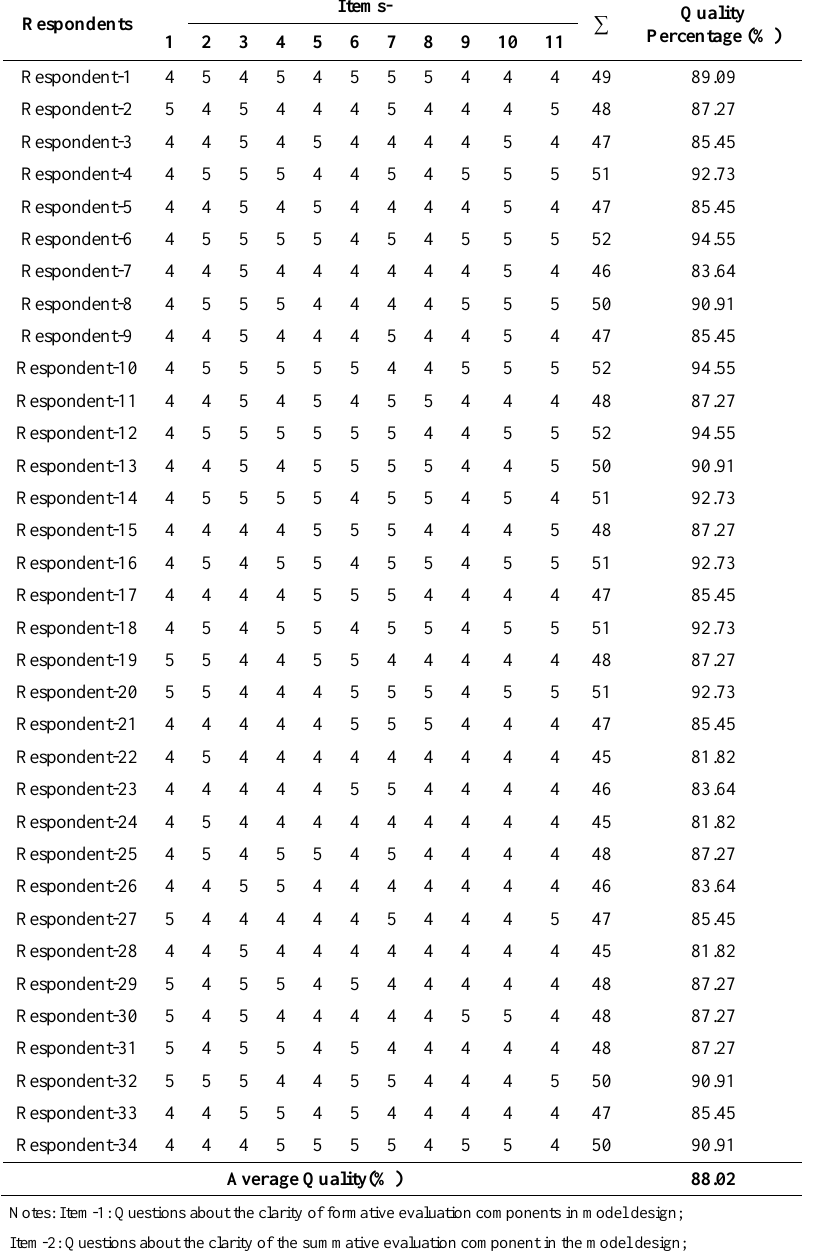
Table 8. The Trial Results of the Formative-Summative Evaluation Model Design based on the Tri Pramana-Weighted